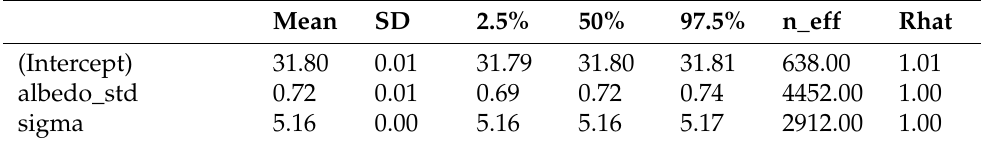
Table A4. Summary of model on effects of standardized albedo on surface